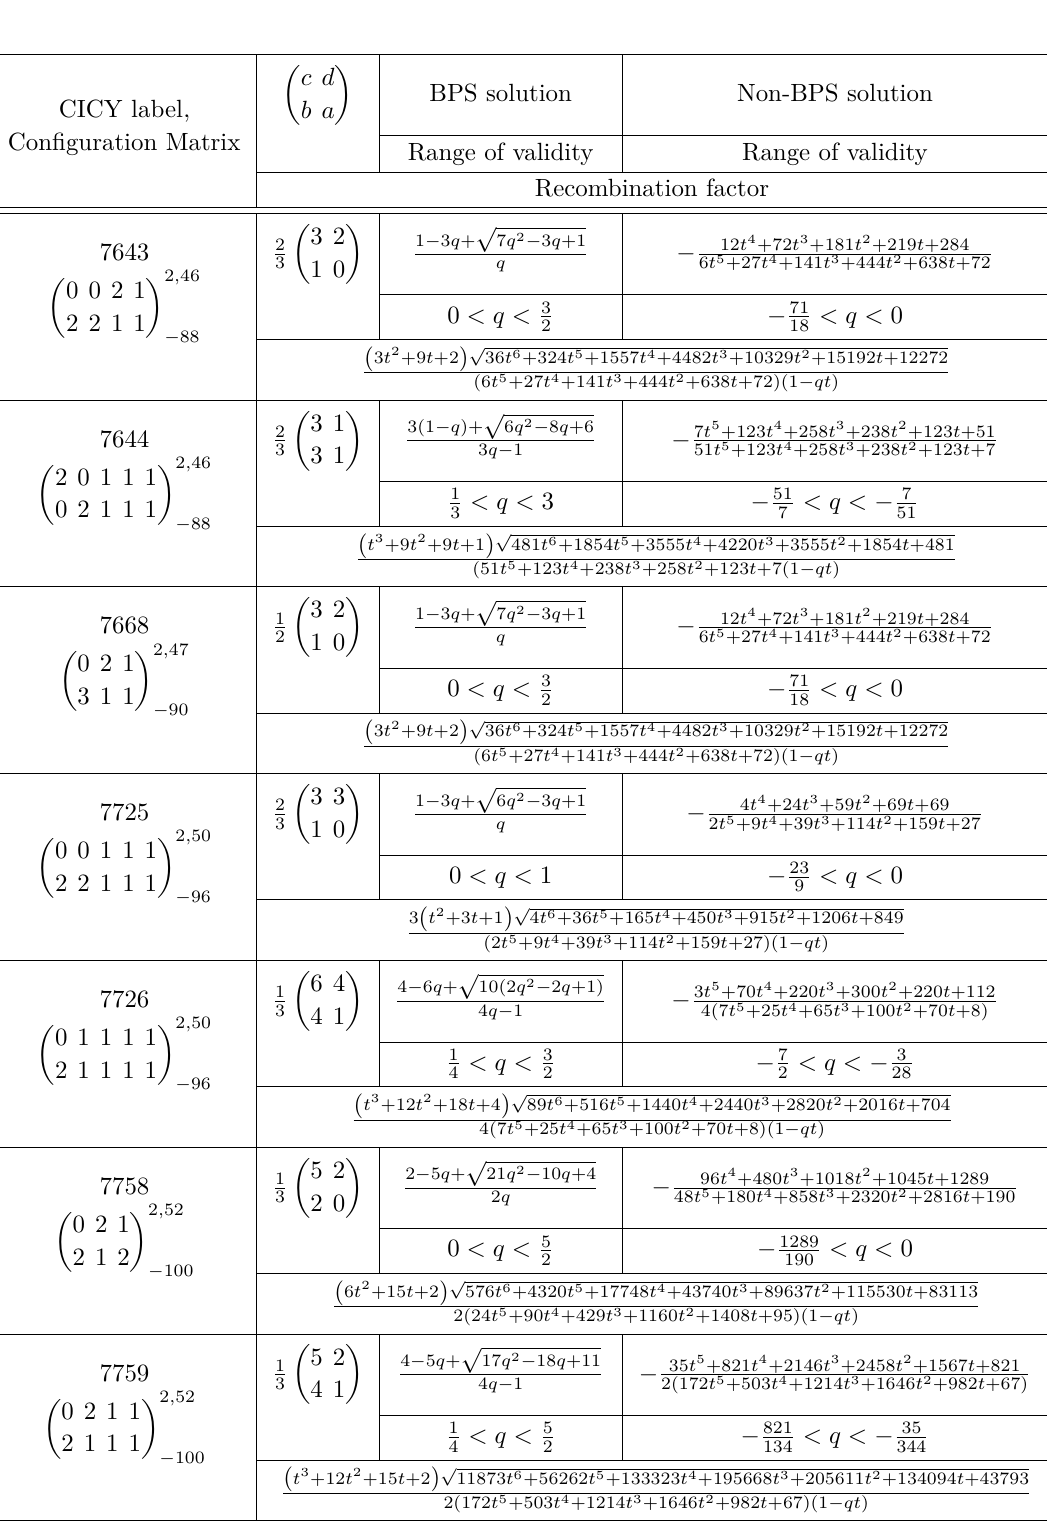
Table 1 . BPS and non-BPS extremal black holes in one-modulus CICY models,